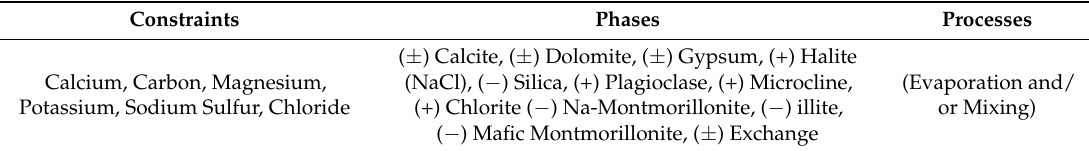
Table 1. Constraints, phases, and parameters used in NETPATH models for the El-Dabaa